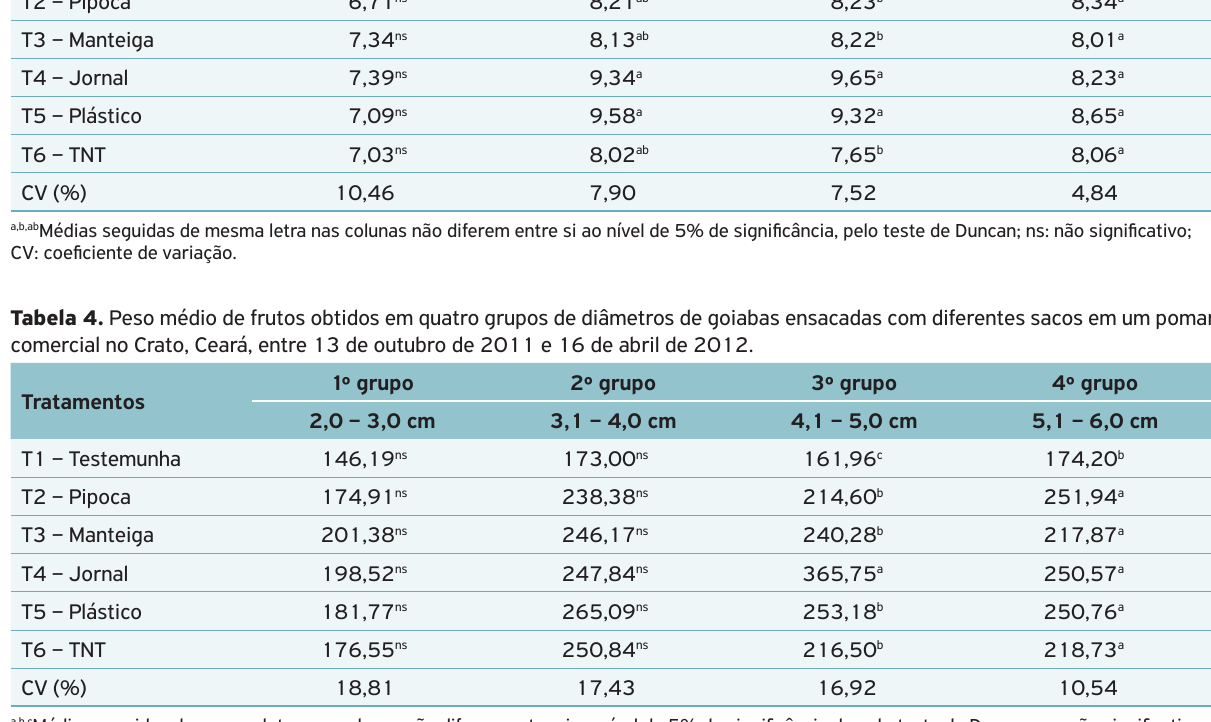
relação comprimento/diâmetro quando comparados aos frutos com saco de papel manteiga e com a testemunha.